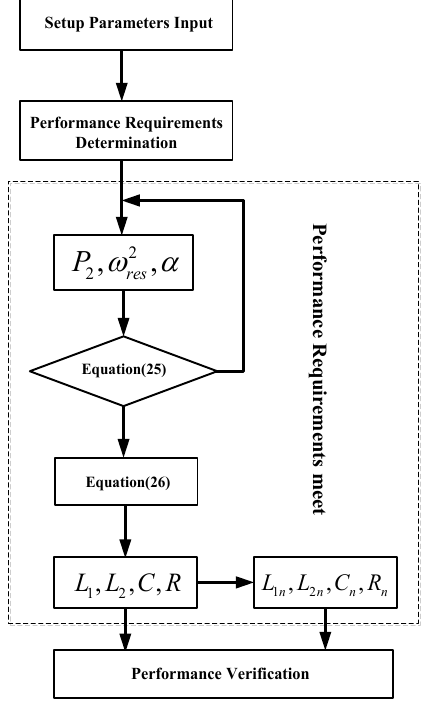
Figure 9. Flowchart of the LCL